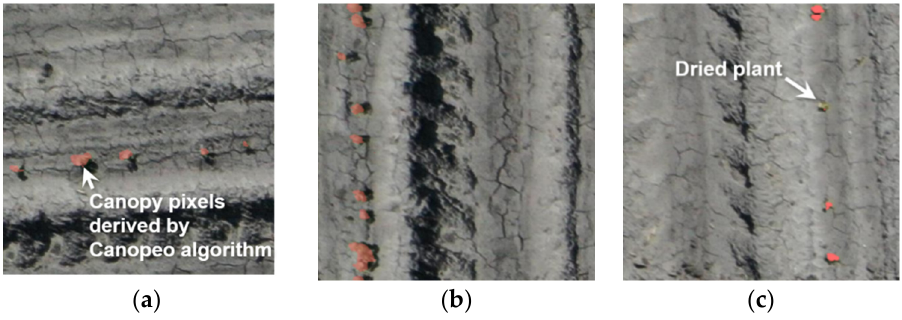
Figure 10. Canopy pixels (red) overlaid on RGB images showing that ( a – c ) the majority of green plant pixels are correctly classified as canopy class by the Canopeo algorithm, whereas ( c ) off-green plants are not.